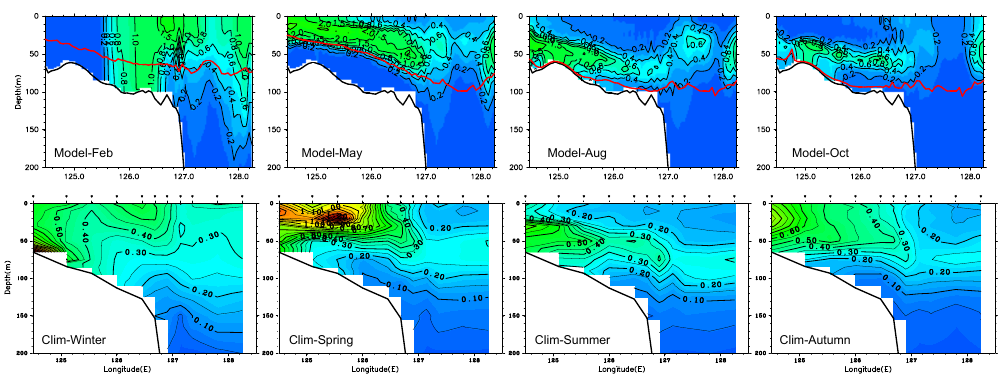
Fig. 7. The same as Fig. 6 but for chlorophyll a (mgm − 3